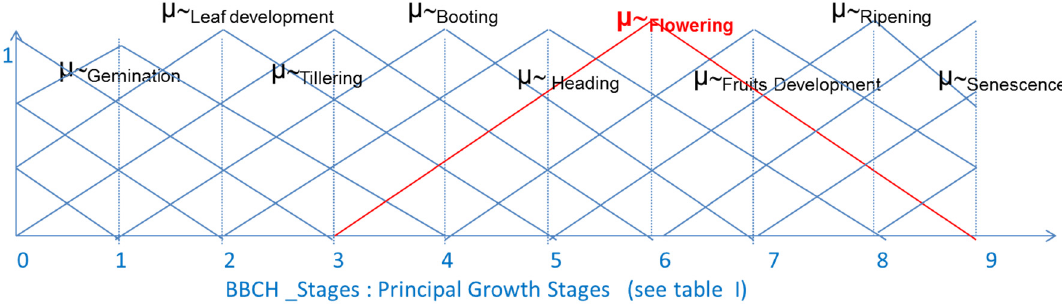
Figure 7. membership functions of the Fuzzy BBCH values (identified by ~prefix) defined on the BBCH stages of the first level in Table 1.